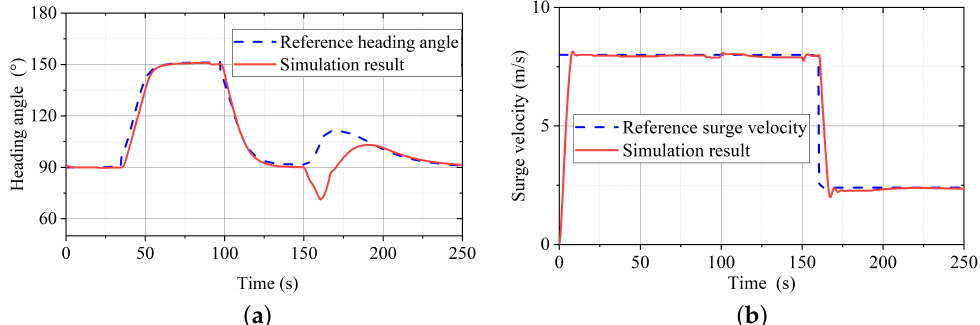
Figure 5. Zig-zag path following results. ( a ) Without surge velocity reconfiguration; ( b ) With surge velocity reconfiguration.